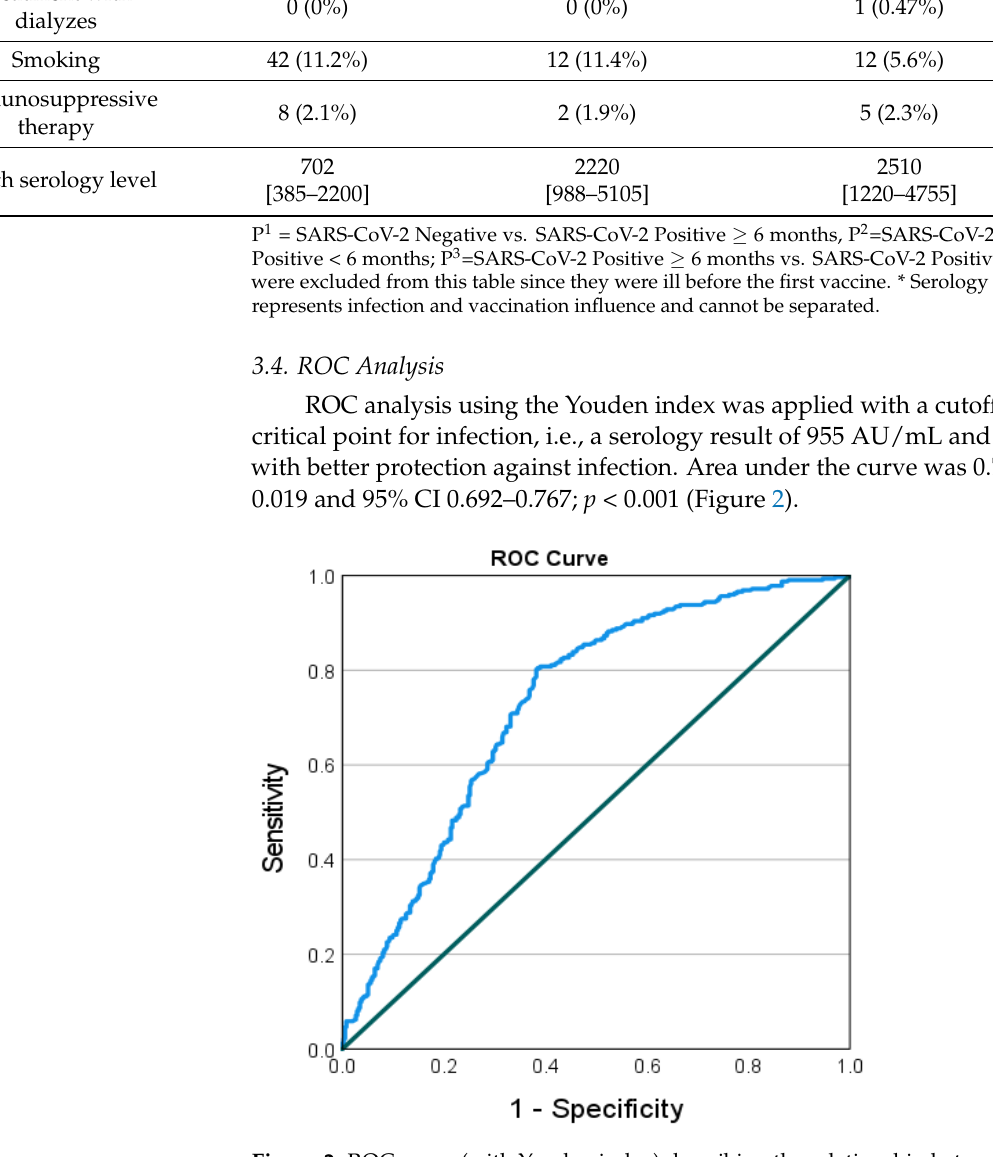
Figure 2. ROC curve (with Youden index) describing the relationship between the sensitivity and the false positive rate for different values of the sixth serology identifying workers at risk for disease. In addition, the average serology levels among HCW who were positive for SARS-CoV-2 (less than six month after vaccination and more than six months after vaccination) were much higher than those who weren’t ill (2410 and 2220 vs. 702, respectively, p < 0.001) (Table